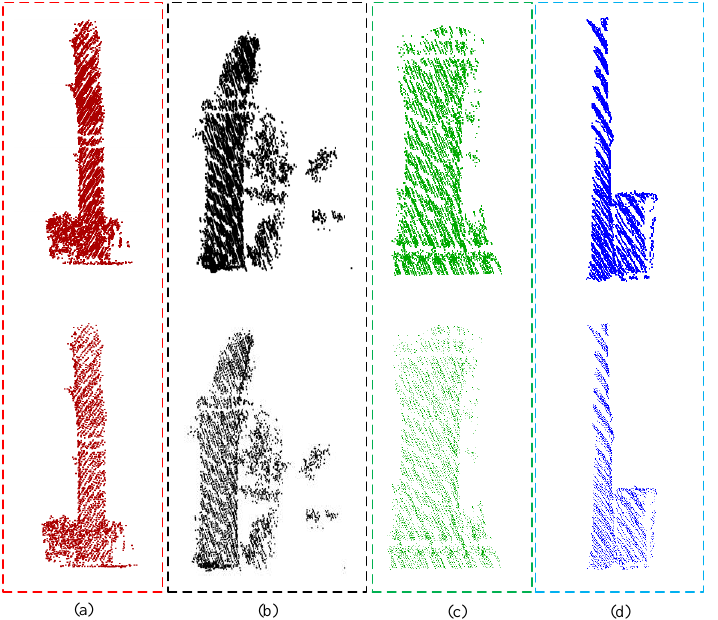
Figure 6. BIRCH calculation result of four samples: Four trunks with much noise: ( a ) Sample 1; ( b ) Sample 2; ( c ) Sample 3; ( d ) Sample 4. The top half of the graph shows the original data and the bottom half is the results of BIRCH clustering.